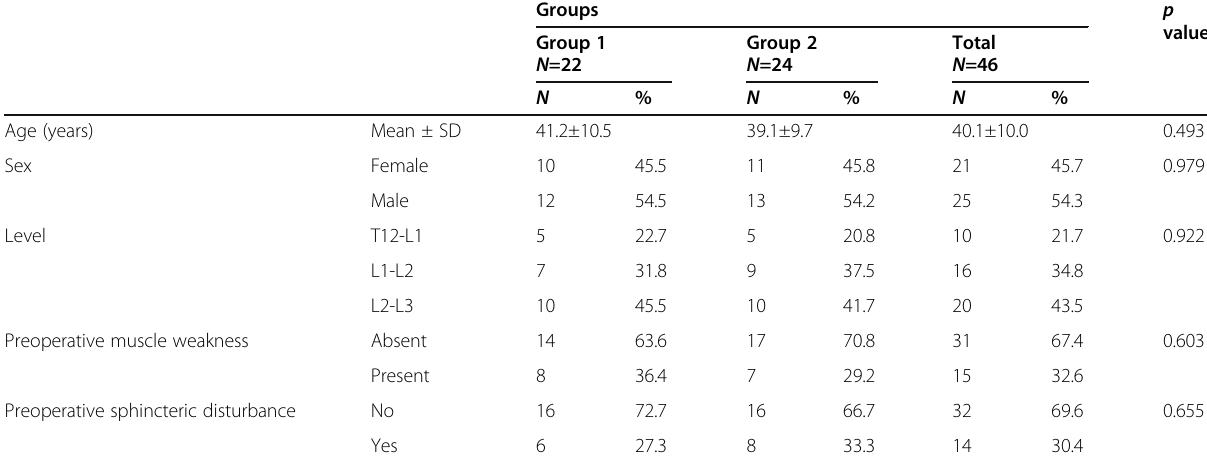
Table 1 Patient demographics and baseline characteristics